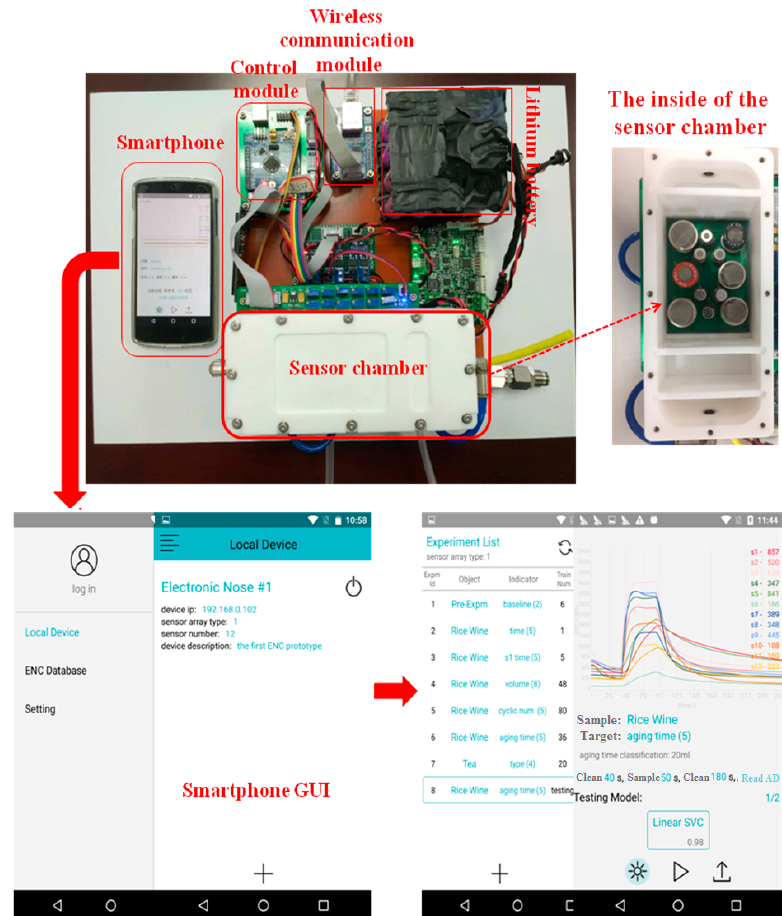
Figure 1. The set-up of the Smartphone electronic nose.